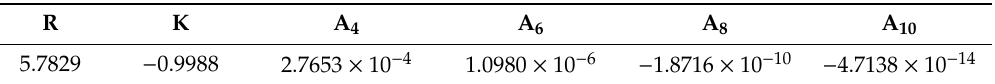
Table 1. Aspheric coe ffi cients of the ideal lens.